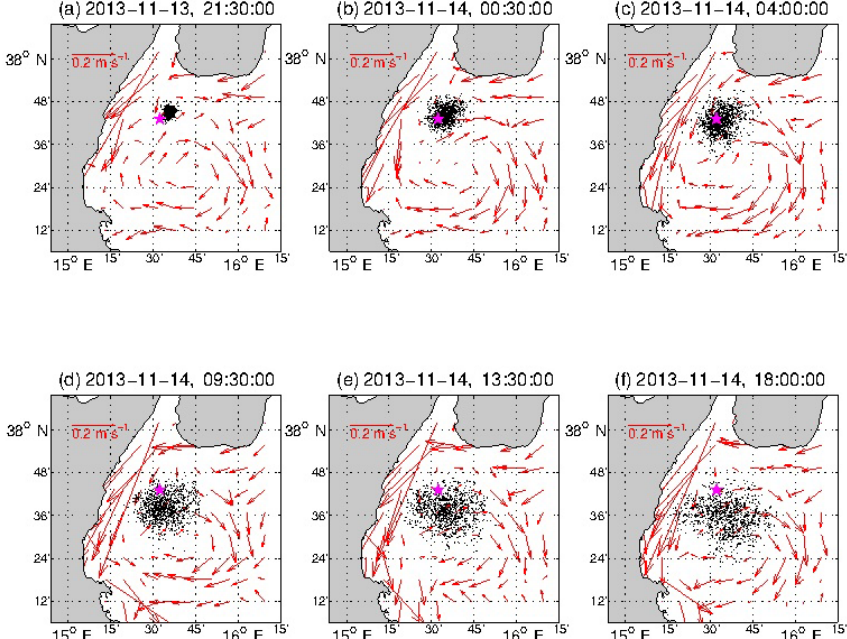
Figure 17. Particles’ dispersion in the Sicilian Channel experiment, overlapped on the hydrodynamic field. The particles’ cloud is planted on the external part of an anticyclonic vortex, where the current flowing along the southern Calabria coast interacts with the strong current coming from the north, where the Messina Strait is located. The particles are driven according to the surface circulation